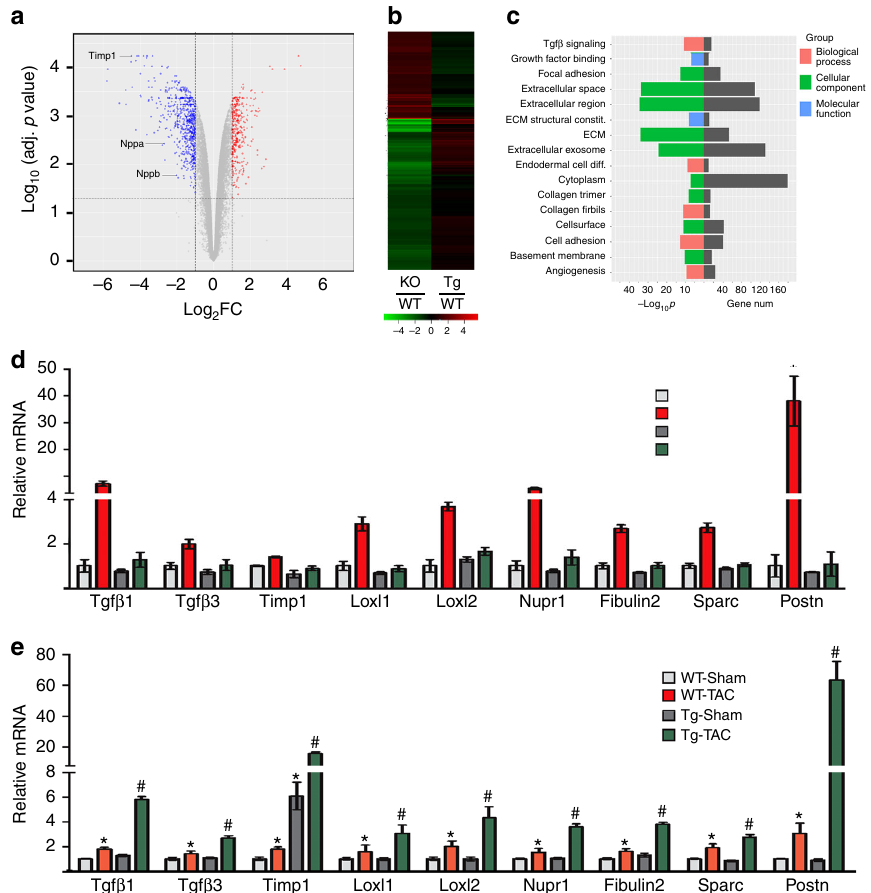
Fig. 4 KDM3A promotes transcription of a pro- fi brotic gene program. a Volcano plot of differentially expressed genes in Kdm3a KO mouse hearts compared to those in WT mouse hearts at 6 weeks post-TAC surgeries. Timp1 is among the most downregulated genes in KO hearts. b Heatmaps of differentially expressed genes in KO vs WT and Kdm3a -Tg vs WT mouse hearts at 6 weeks post-TAC surgery, showing differentially expressed genes are inversely regulated in KO vs Tg hearts. c GO analysis of differentially downregulated genes in KO vs WT TAC mouse hearts. Relative mRNA of genes involved in fi brosis in Kdm3a -/- ( d ) and Kdm3a -Tg ( e ) mouse hearts 6 weeks post-Sham and TAC surgery. mRNA transcripts were measured by qRT-PCR, normalized against internal Gapdh, and expressed relative to Sham WT mice. n = 5 ± SEM. * , # p < 0.05 (ANOVA). *, WT TAC vs. WT Sham. # , Tg-TAC